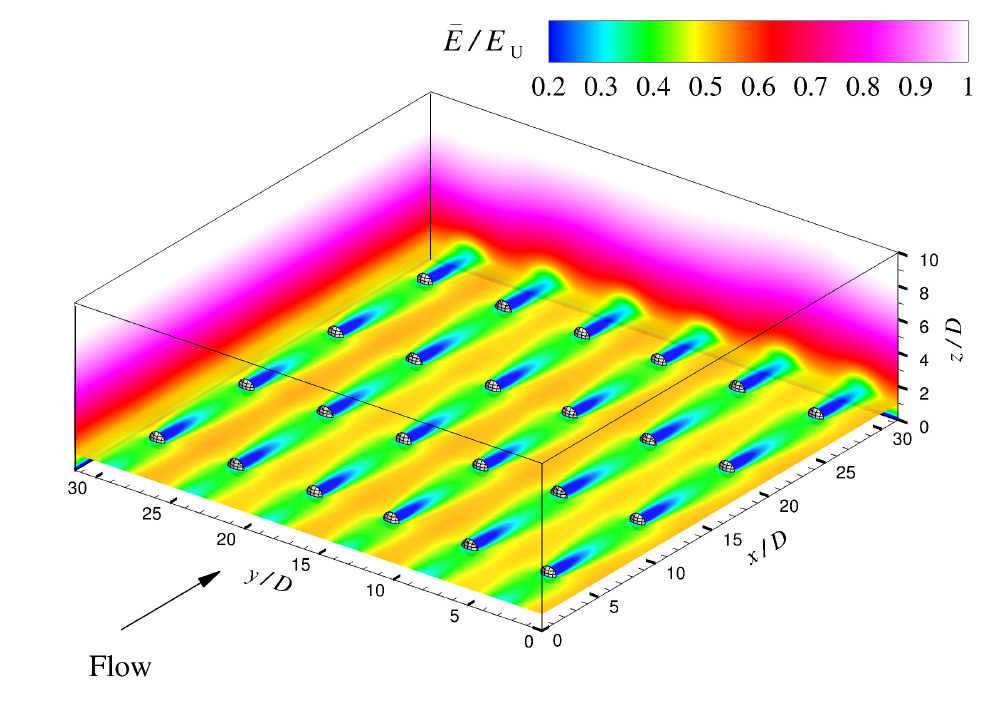
¯ u ¯ u , normalized by the kinetic i i 2